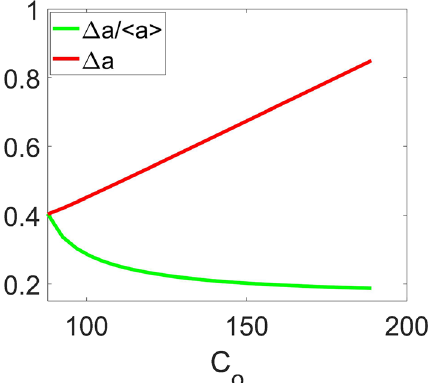
Fig. 8 Variations in the quantum fluctuation versus the coherence. The horizontal axis represents the coherence. The parameters are taken as: p a = 10, α = 0 . 5, V 0 = 200 (cid:14) a ) are more rapid. Equation (75) shows that if we increase the parameter p a (and fixing the parameters α and V 0 ), then the parameter α 0 will be increased. Semiclassically, increas- ing α 0 means increasing the temperature of the initial state of the universe ( χ 0 ∼ α 0 and α 0 ∼ (cid:7) a (cid:2) T ). Thus these figures show that the higher initial universe temperature is related